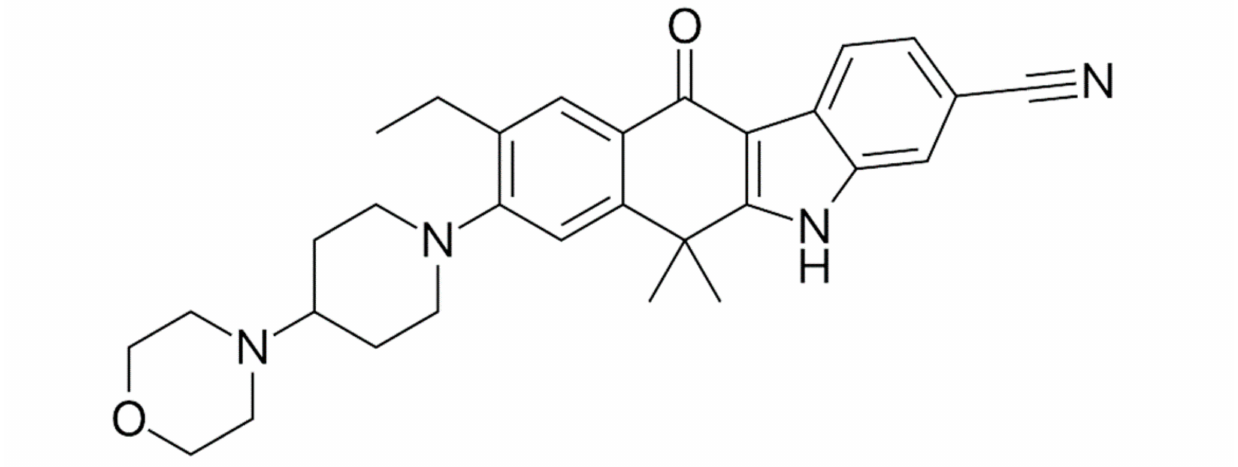
Figure 9. Alectinib—a second-generation ALK